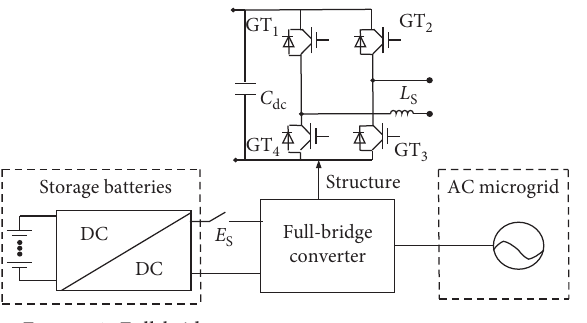
Figure 3: Full-bridge equivalent